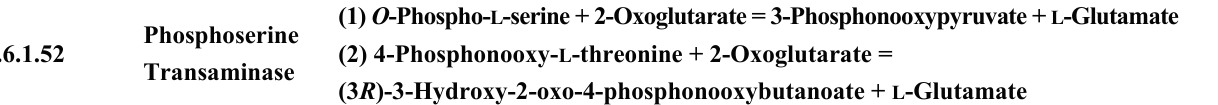
Table 5. Phosphoserine transaminase expression (“control”